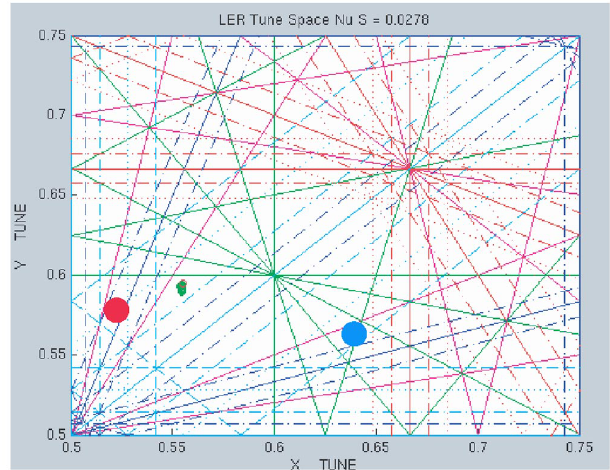
FIG. 20. (Color) Intensity of the LHC beam versus time after injection at the CERN SPS in 2000: relative total intensity (top) and relative bunch intensity for four bunches at the start and in the tail of the train (bottom) [5]; losses after a few ms are visible for the trailing bunches; the intensity was measured every seven turns for a span of about 20 ms.